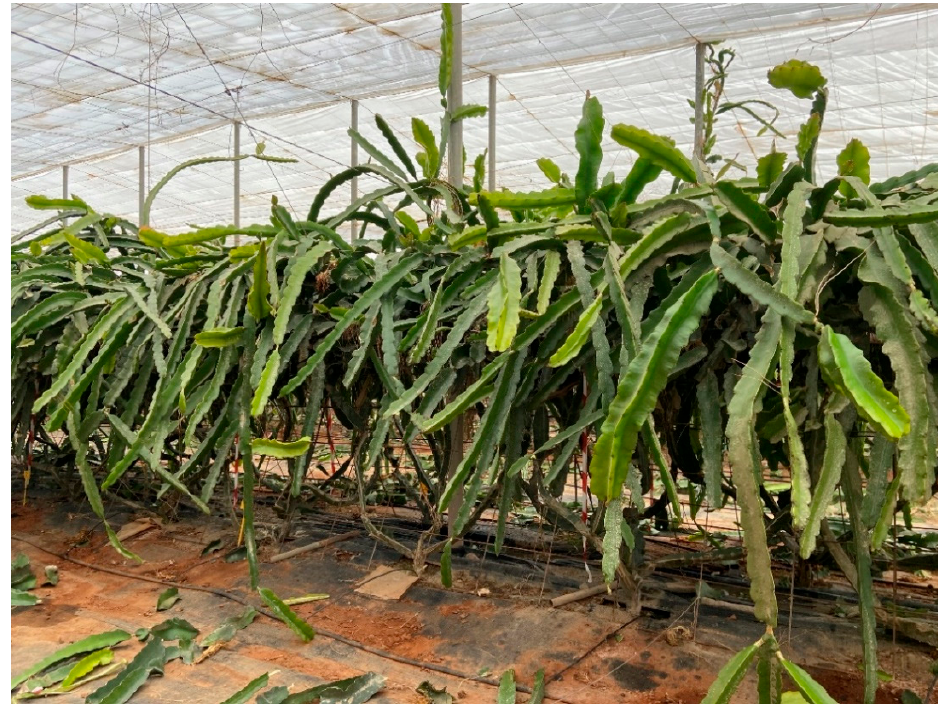
Figure 3. Partial view of the greenhouse and pitaya training system.